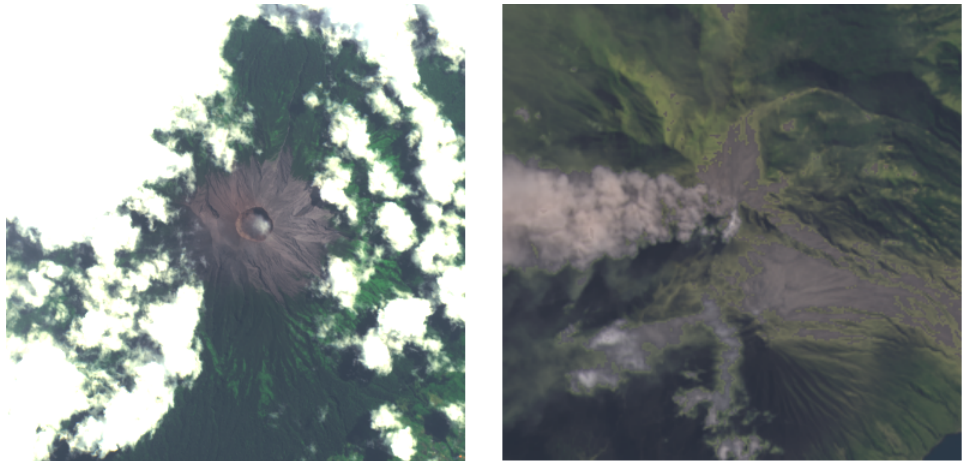
Figure 2. Volcano surrounded by clouds ( left ) vs. Eruption smoke ( right